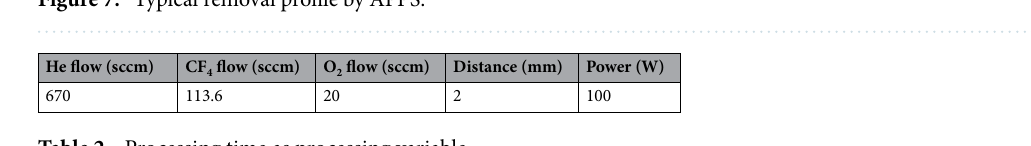
Table 2. Processing time as processing variable.